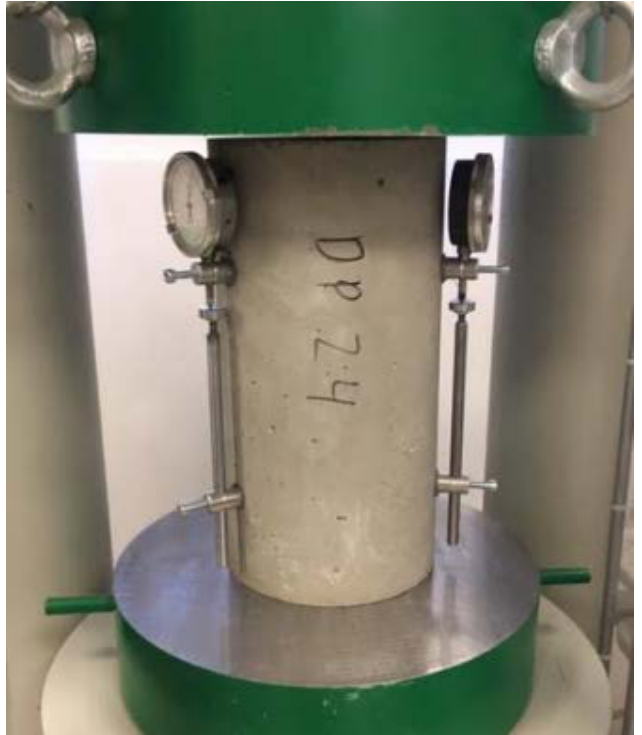
Figure 6. Testing of the secant modulus of elasticity at compression.